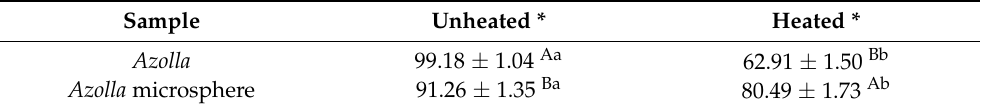
Table 1. Antioxidant activity of free and microencapsulated Azolla before and after heat treatment.